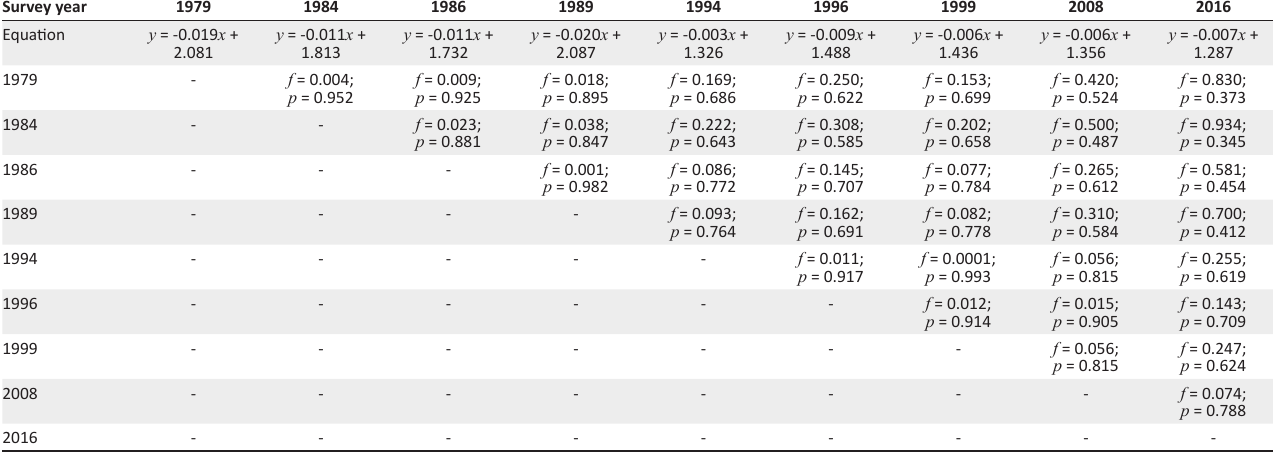
TABLE 3-A1: Statistical comparison of intercept values for linear regressions fitted on the density of individuals against the diameter class midpoint of live trees at Grootkolk in the Kalahari Gemsbok National Park using an analysis of covariance. Survey